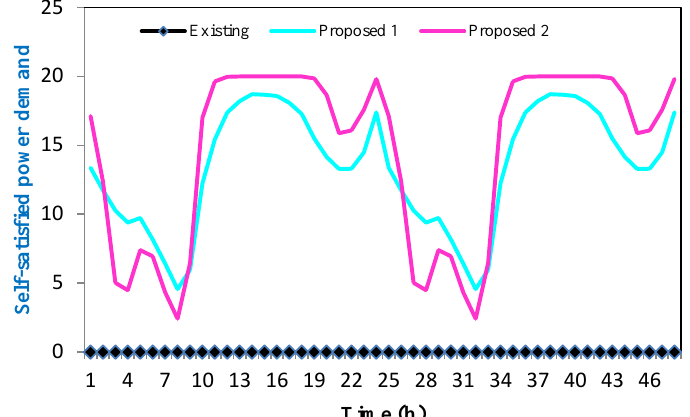
Figure 17. Comparison of self- satisfied power demand between existing and proposed scenarios over 48 h time period.